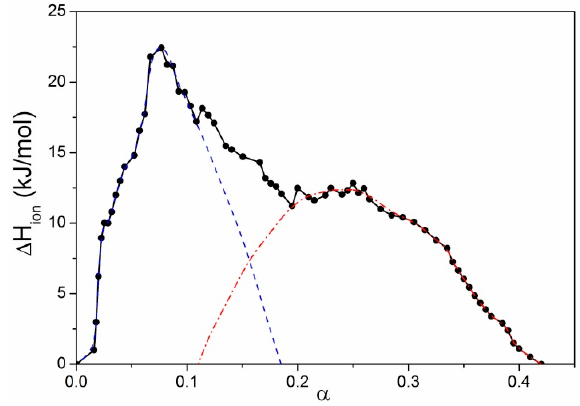
Figure 5. More precise calorimetric titration ( Δ H ion versus α curve) for iPMA in 0.01 M NaCl at 25 °C. The points are experimental values connected by the solid black line. The black and red lines designate the two superimposed peaks in the low (dashed blue line; integration of this peak resulted in the Δ H ass value) and high (dotted red line; integration of this peak resulted in the Δ H conf value) α region. For details on integration procedures and interpretation of these Δ H values see text.